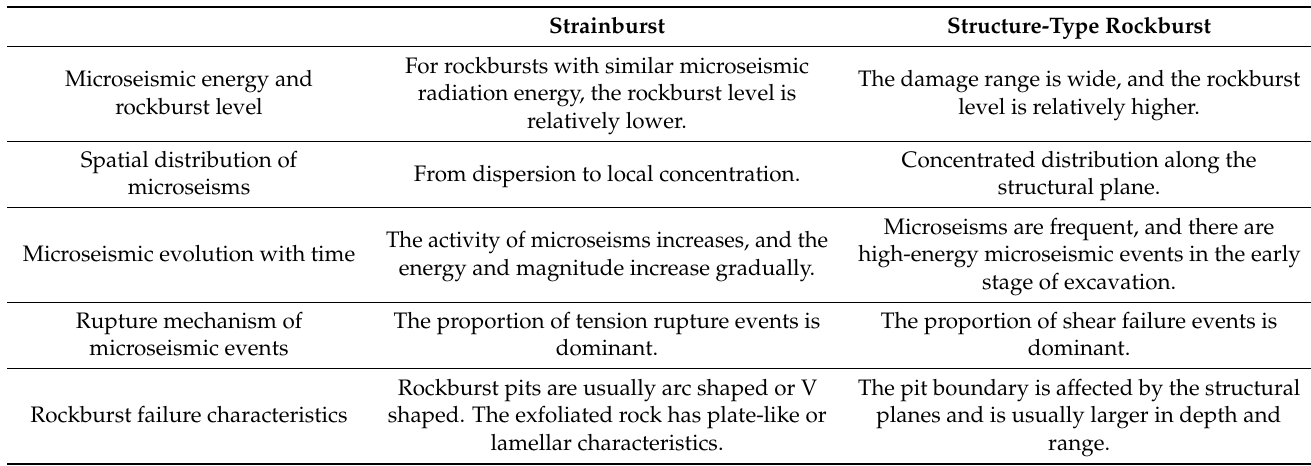
Table 1. Comparison of typical characteristics between strainbursts and structure-type